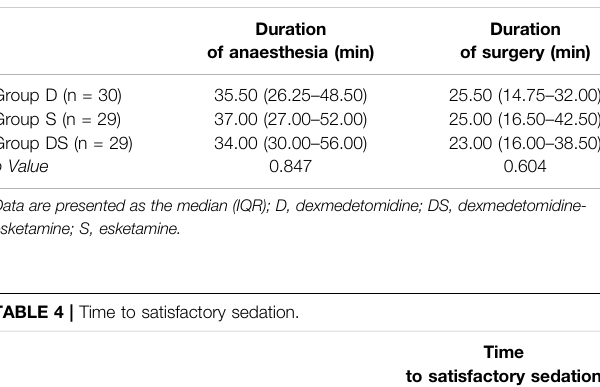
TABLE 3 | Duration of anaesthesia and surgery. TABLE 5 | Comparison of anaesthesia